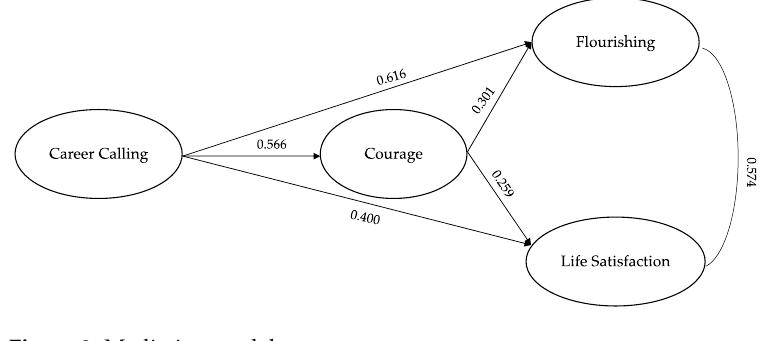
Figure 2. Mediation model.